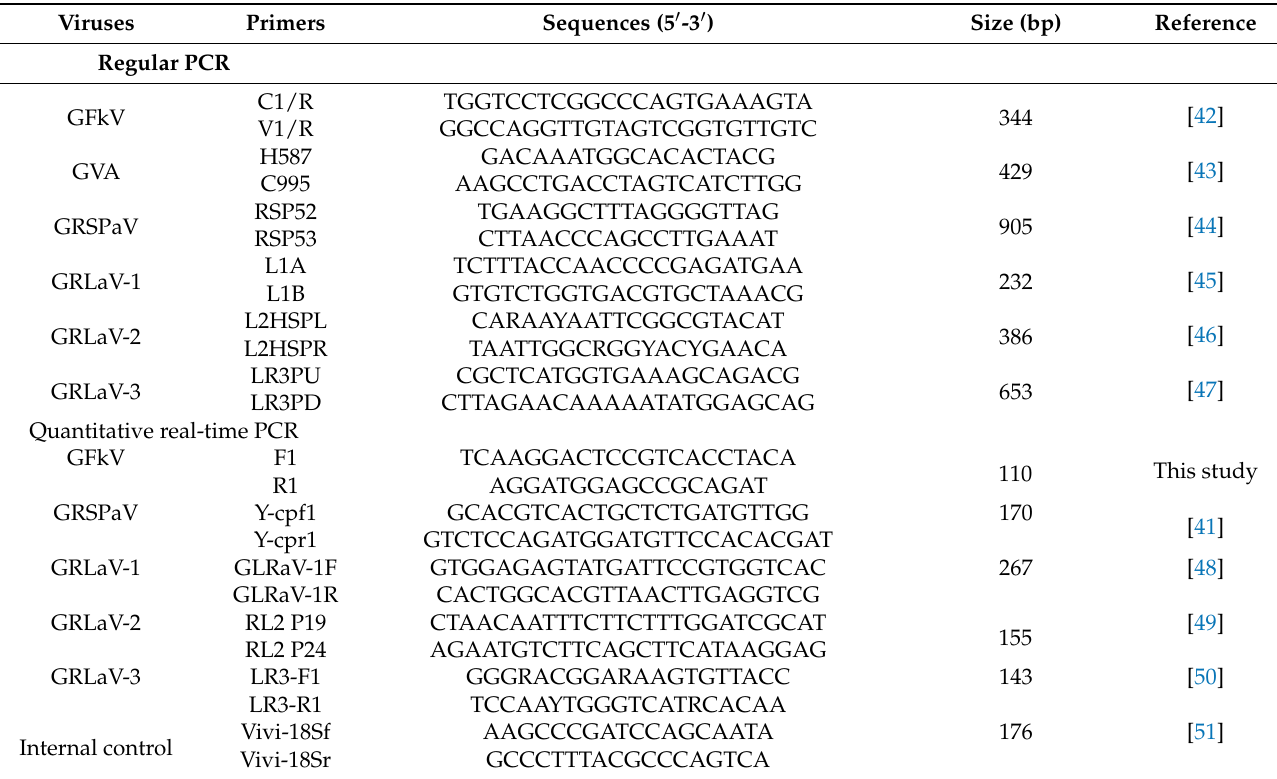
Figure 4. Sampling of long shoot tip culture. Table 3. Primers used for grapevine virus